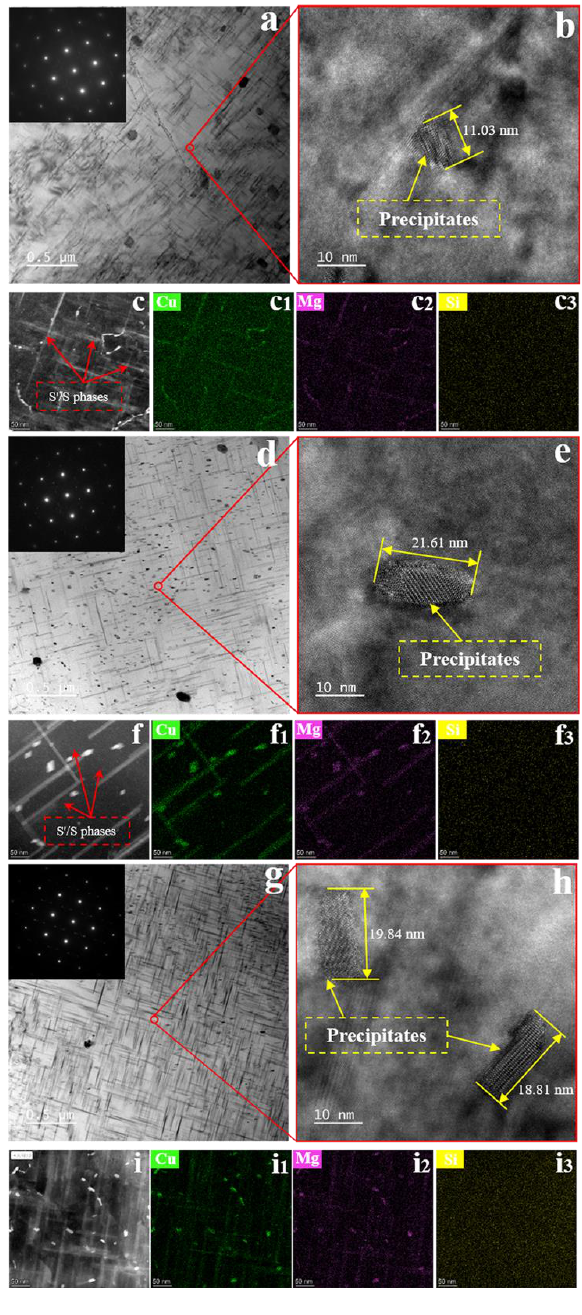
Figure 4. Microstructure without SMGT alloys aged at 210 °C for different times. Bright-field TEM images with an inset of the representative selected area diffraction pattern: ( a ) 6 min, ( d ) 27 min, and ( g ) 60 min. The corresponding high-resolution TEM images are indicated in ( b , e , h ), respectively. The size of the precipitate is marked in the high-resolution TEM images. HAADF-STEM images of precipitate region are displayed in ( c , f , i ), respectively. The corresponding EDS elemental mappings are shown in ( c 1 – c 3 ), ( f 1 – f 3 ), and ( i 1 – i 3 ), respectively.